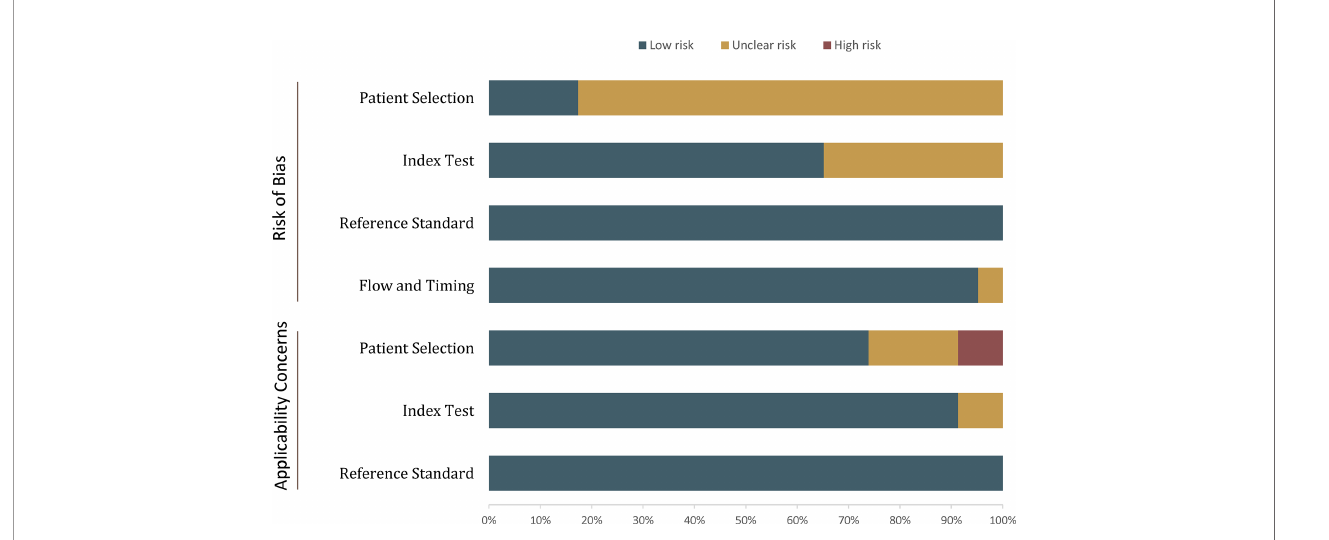
FIGURE 2 | Grouped bar charts show the risk of bias and concerns for applicability of included